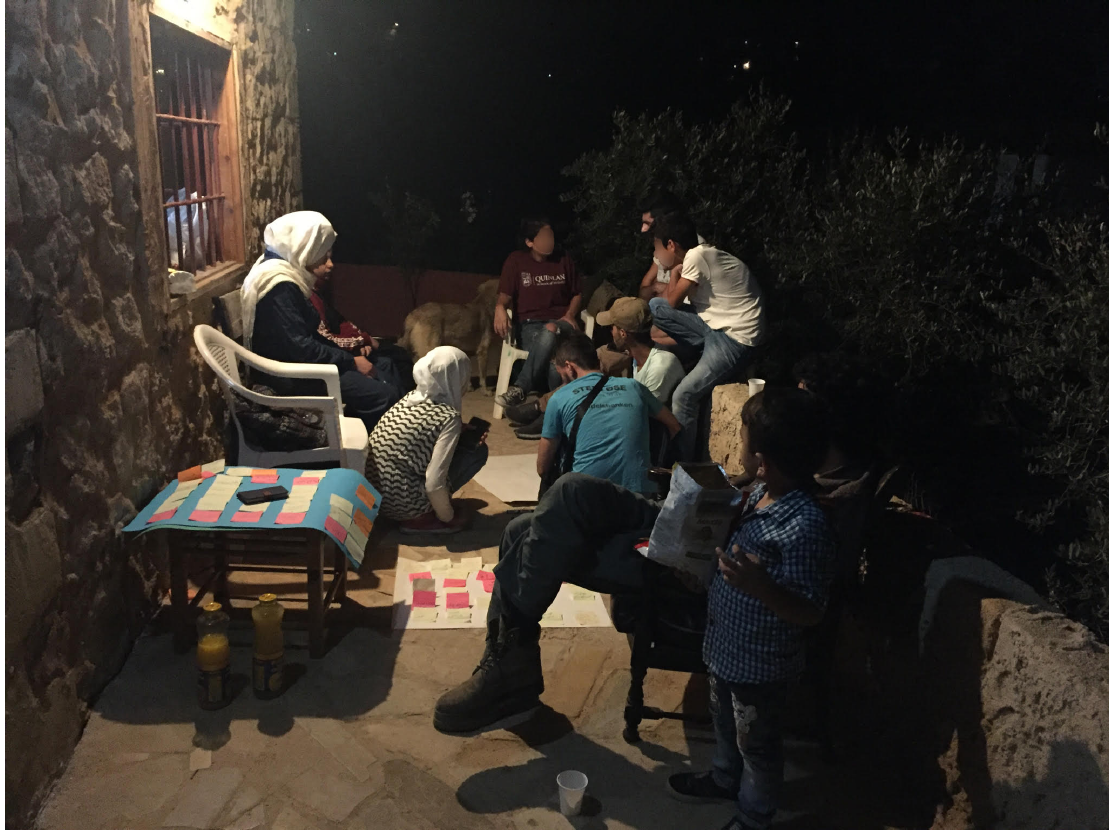
Figure 1. Settings of the participatory design workshop with the Syrian refugees in